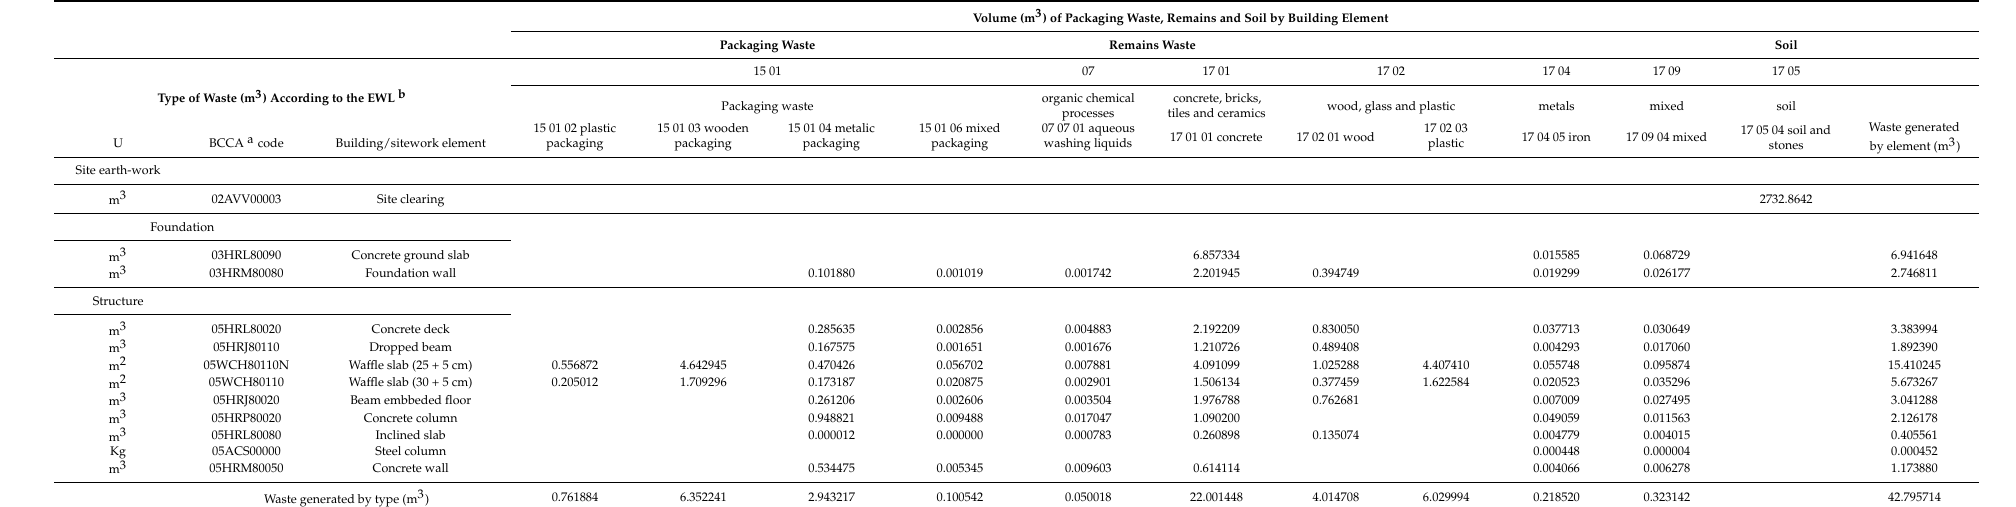
Table 5. Construction waste expected by building elements, obtained in Allplan, Archicad, and